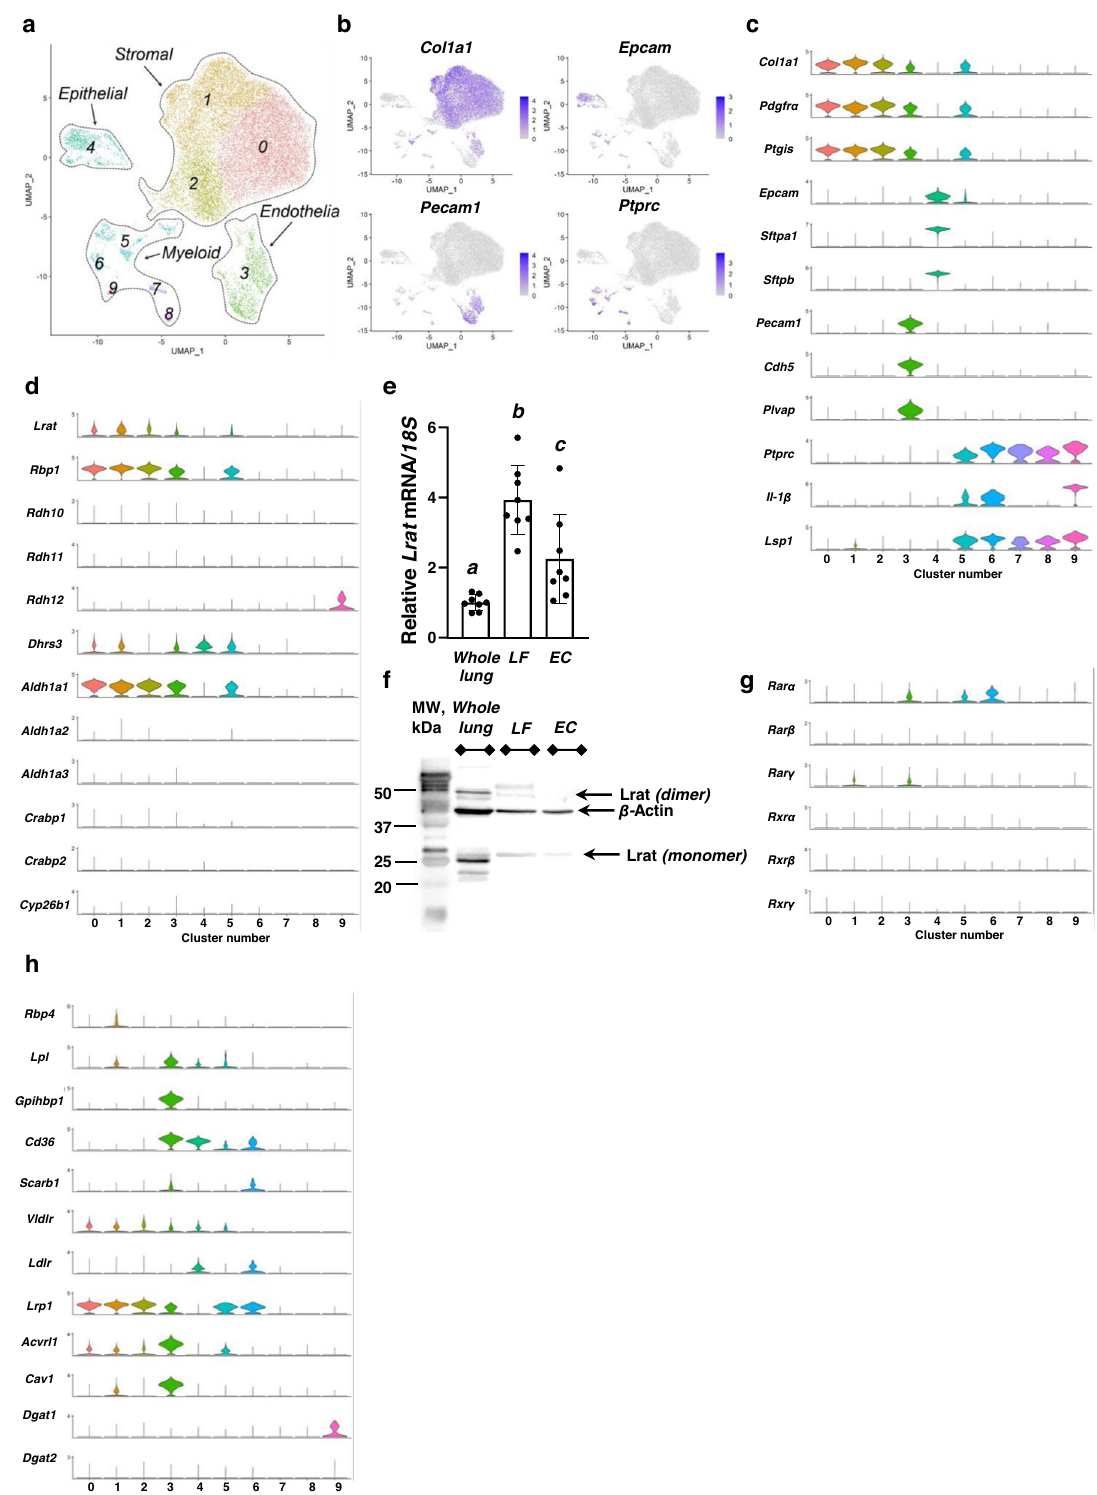
clusters identi fi ed in our study into several previously reported cell groups (Fig. 4b). The comparative analysis of the transcriptional sig- natures allowed us to conclude that the majority of stromal clusters identi fi ed in our dataset were enriched with markers indicative of different types of matrix fi broblasts (Fig. 4b) but depleted in markers for myo fi broblasts, pericytes, fi bromyocytes, mesothelial cells, and airway smooth muscle cells (Supplementary Fig. 8) 82 – 86 . This